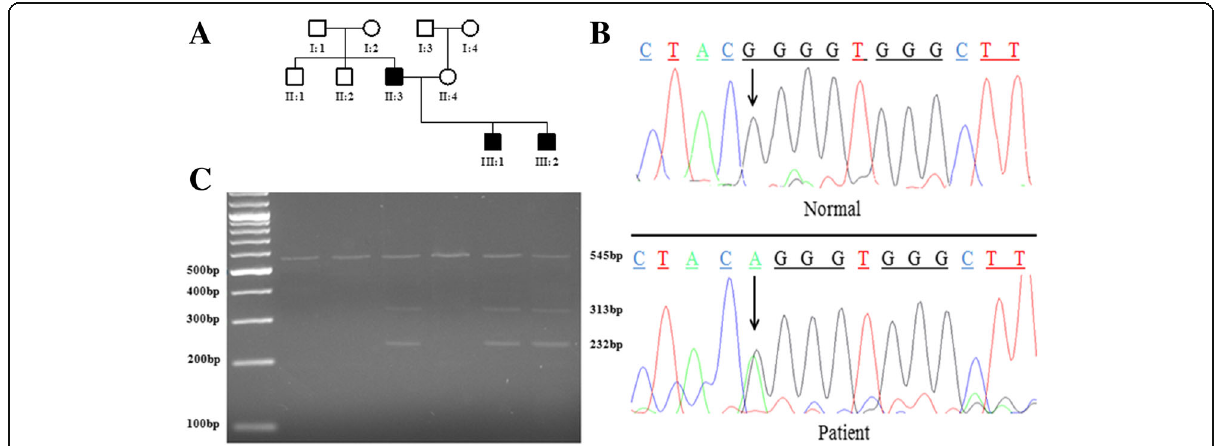
Fig. 2 The ACH family pedigree and DNA sequence analysis: ( a ) Pedigree of a non-consanguineous Pakistani family where ACH is segregating as dominant trait. Three affected individuals (II-3, III-1, III-2) and three phenotypically healthy individuals (II-1, II-2, II-4) were analysed. b Sanger sequencing of FGFR3 gene revealed a c.1138 G > A heterozygous mutation in affected individuals while homozygous wild-type allele (G/G) in phenotypically healthy individuals. Arrow indicates the site of mutation. c PCR-RFLP analysis; an electrophoretic banding pattern of SfcI digestion revealed homozygous status for all healthy individuals while heterozygous condition observed in affected